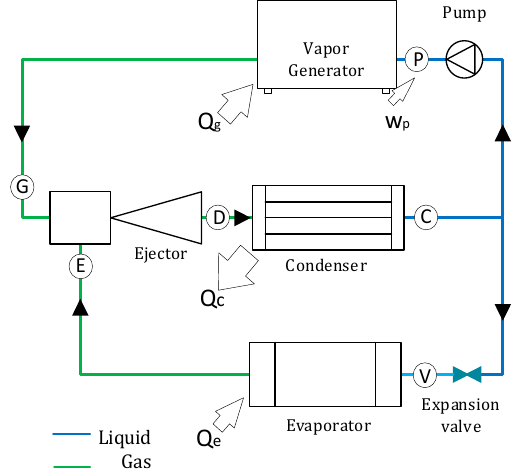
Figure 2. The basic working cycle of an ejector refrigeration system.